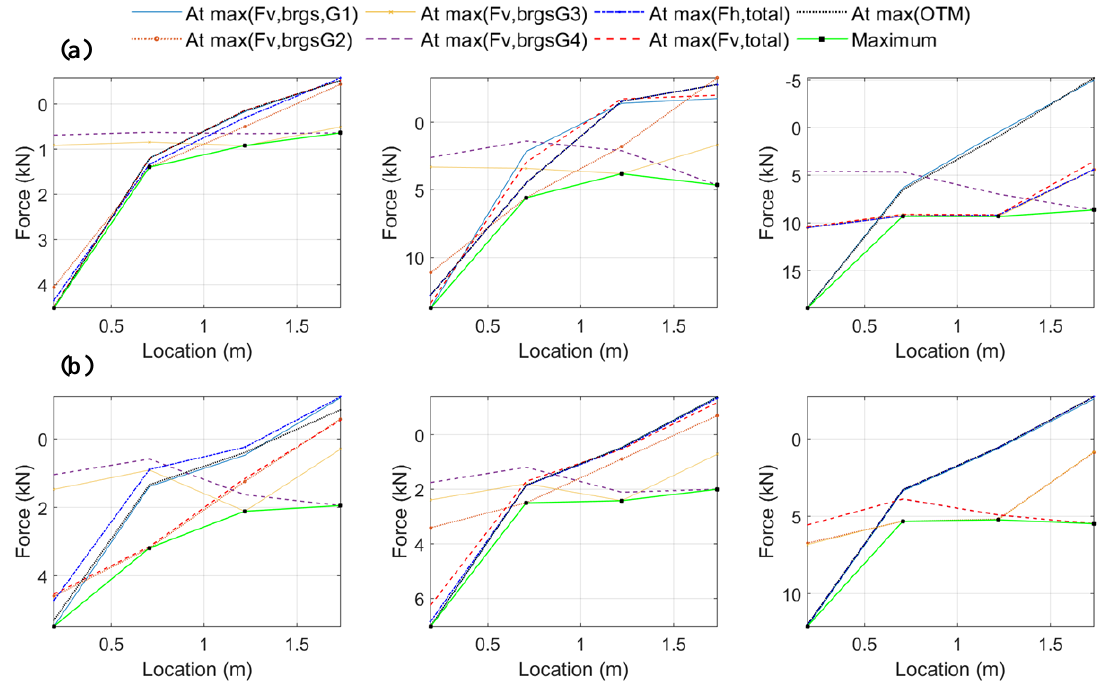
Figure 22. Recorded bearing forces at different instants for ( a ) solitary waves (top) with H = 0.42 m (left), H = 0.55 m (center) and H = 0.70 m (right), and ( b ) bores (bottom) with H = 1.0 m (left), H = 1.10 m (center) and H = 1.40 m (right).